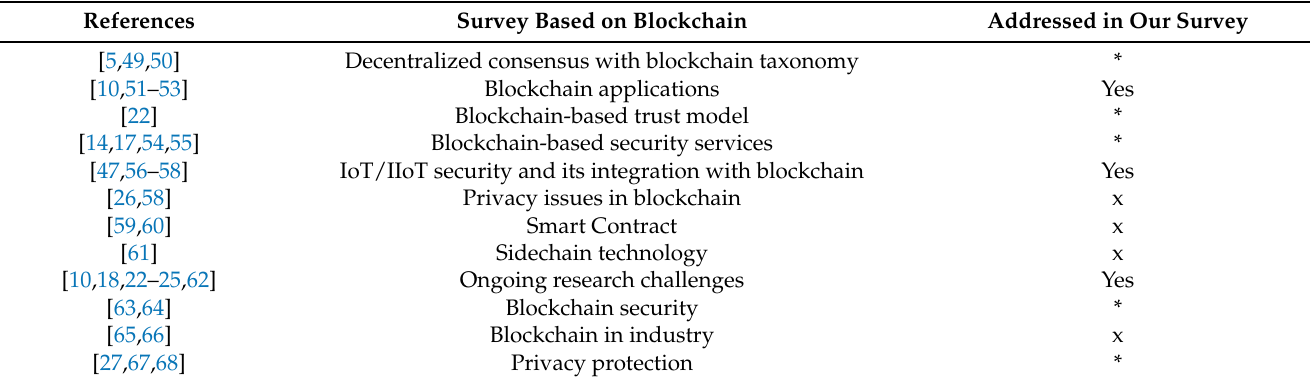
Table 3. Content discussed in different surveys based on Blockchain (x is for not covered, * is for partially